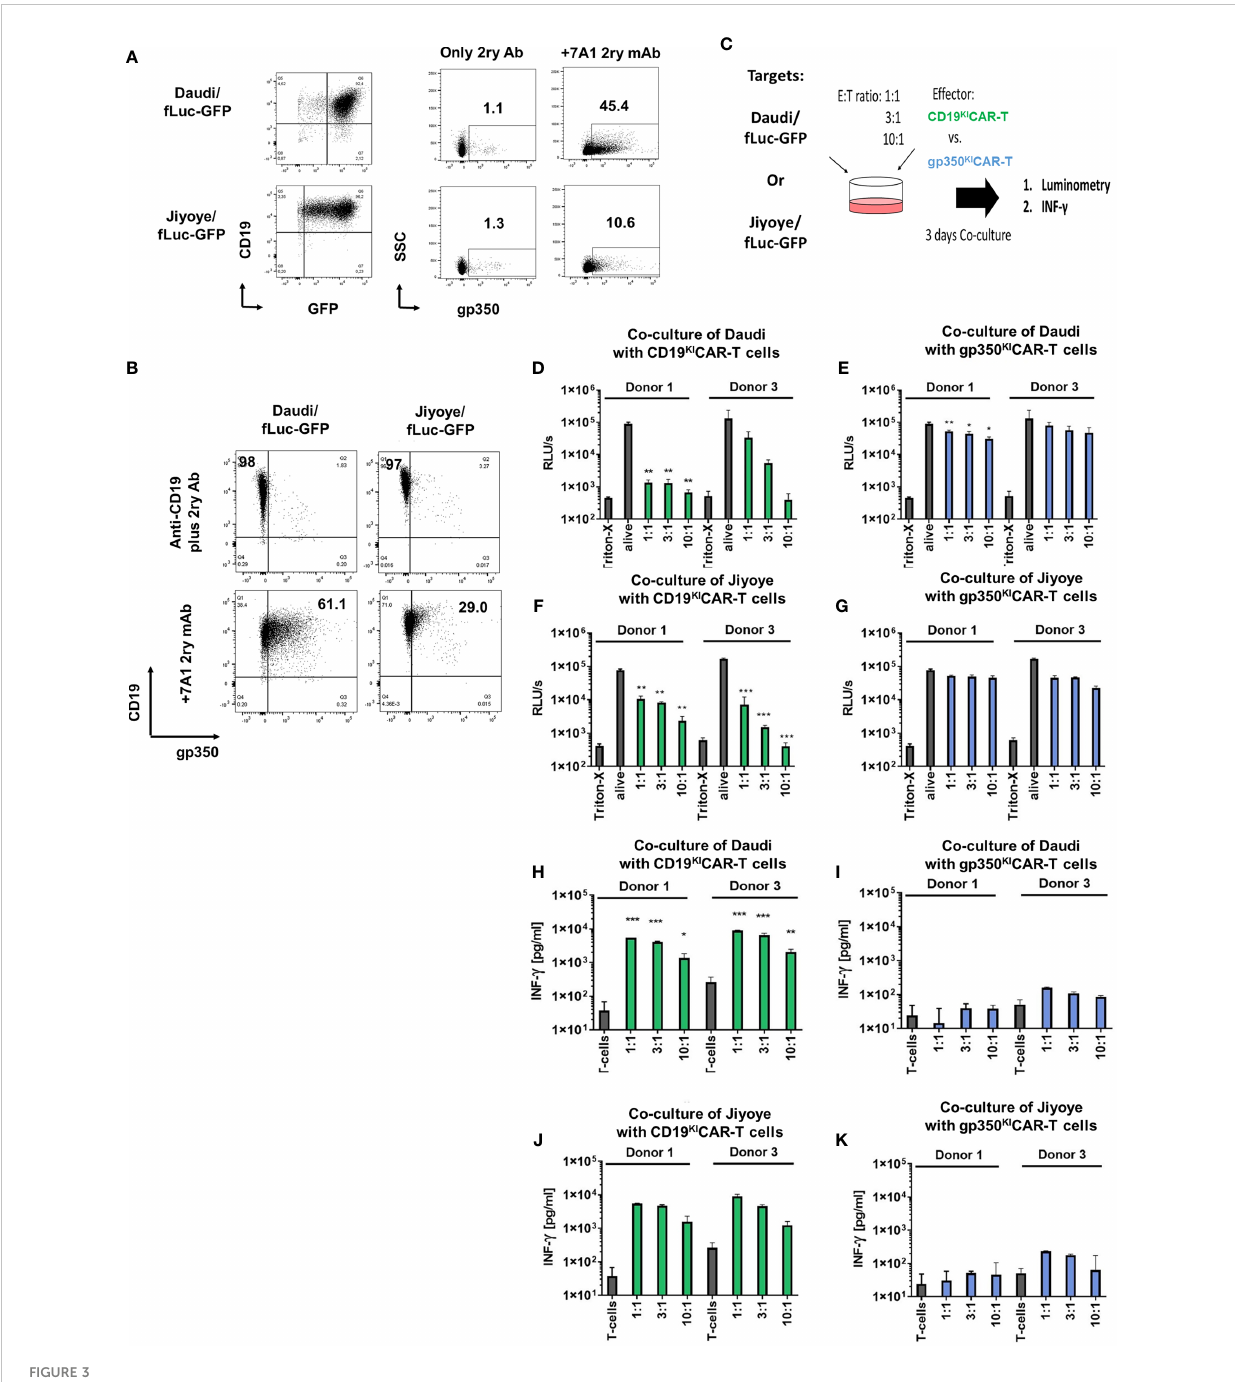
FIGURE 3 CD19 KI CAR-T and gp350 KI CAR-T generated on a small scale recognized and killed Daudi/fLuc-GFP (EBV + type 1) and Jiyoye/fLuc-GFP (EBV + type 2) cell lines in vitro . (A) Left panels: fl ow cytometry analyses of Daudi/fLuc-GFP and Jiyoye/fLuc-GFP cell lines showing GFP + CD19 + cells. Right panels: speci fi c expression of gp350 after staining with the anti-gp350 7A1 antibody, followed by staining with a conjugated secondary antibody, is shown for each target cell line. (B) More than 97% of the Daudi/fLuc-GFP and Jiyoye/fLuc-GFP cell lines express high levels of CD19, whereas within the CD19-positive cells, only subpopulations of Daudi/fLuc-GFP (61%) and Jiyoye/fLuc-GFP (29%) express variable levels of gp350. (C) Schematic representation for functional analyses of CD19 KI CAR-T and gp350 KI CAR-T cells after co-culture with Daudi/fLuc-GFP or with Jiyoye/fLuc-GFP cell lines at different E:T ratios. After 3 days of co-culture, cells were analyzed by luminometry (relative light units per second; RLU/s) and IFN- g secretion. Triton-X was used to determine the maximum killing rate, whereas non-treated alive cells were used as controls. (D, E) Cytotoxicity effects of CD19 KI CAR-T or gp350 KI CAR-T effectors after co-culture with Daudi/fLuc-GFP targets. (F, G) Cytotoxicity effects of CD19 KI CAR-T or gp350 KI CAR-T effectors after co-culture with Jiyoye/fLuc-GFP targets. (H, I) IFN- g detected in cultures of CD19 KI CAR-T or gp350 KI CAR-T effectors after co-culture with Daudi/fLuc-GFP targets. (J, K) IFN- g detected in cultures of CD19 KI CAR-T or gp350 KI CAR-T effectors after co-culture with Jiyoye/fLuc-GFP targets. Results for CD19 KI CAR-T cells are depicted in green and those for gp350 KI CAR-T cells in blue. The results represent cultures performed in triplicate. Statistical analyses took the form of a one-tailed grouped t-test (***p < 0.001, **p < 0.01, *p <